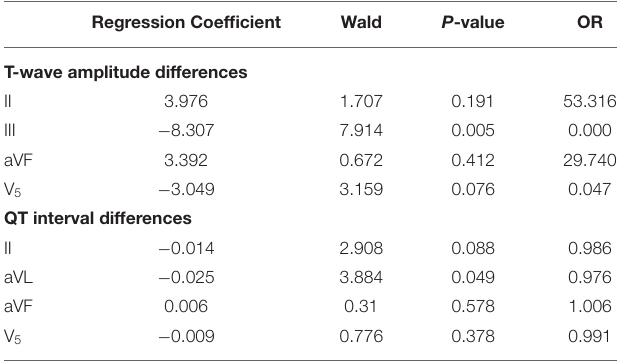
TABLE 1 | Logistic regression analysis of T-wave amplitude differences in leads II and III, aVF, and V 5 and QT interval differences in lead II, aVL, aVF, and V 5 . Regression Coefficient Wald P -value OR T-wave amplitude